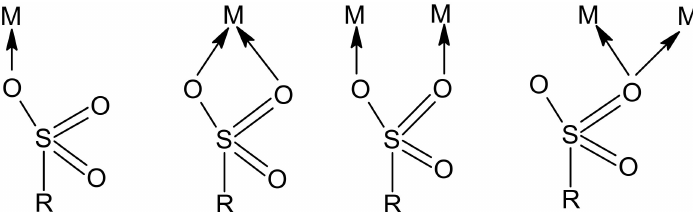
Figure 10. Possible metal coordination with sulfonate groups (own elaboration based on